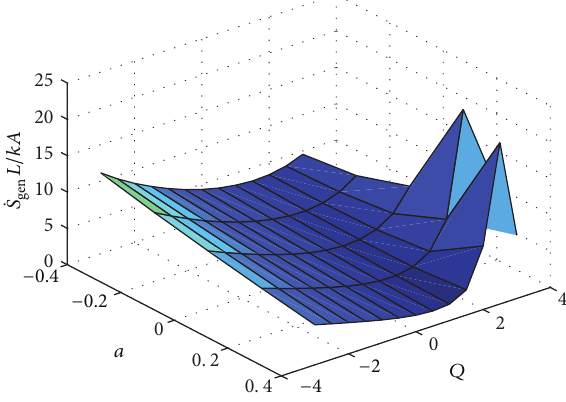
̇𝑆 with respect to “ 𝑎 ” and “ 𝑄 .” gen